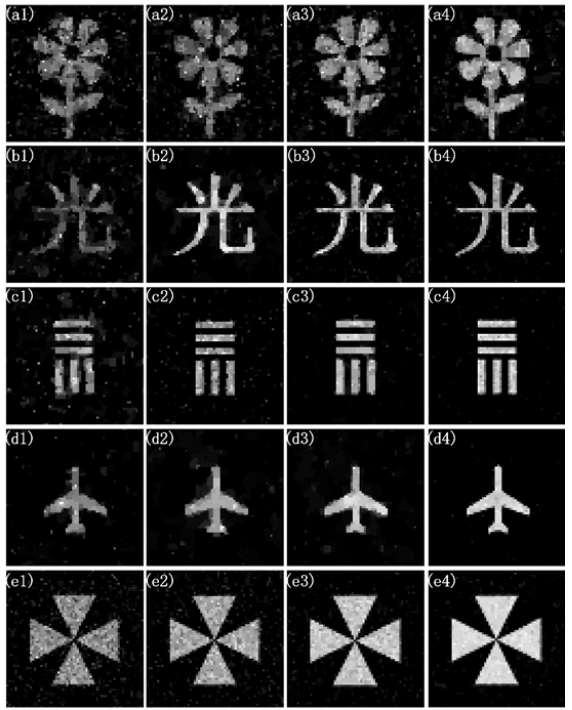
Fig. 8 Reconstruction results of five groups of random matrices at corresponding compressive SR . In a single group of five experiments, the compressive SR s of the four independent groups are set to 0.10, 0.25, 0.50, and 0.75,